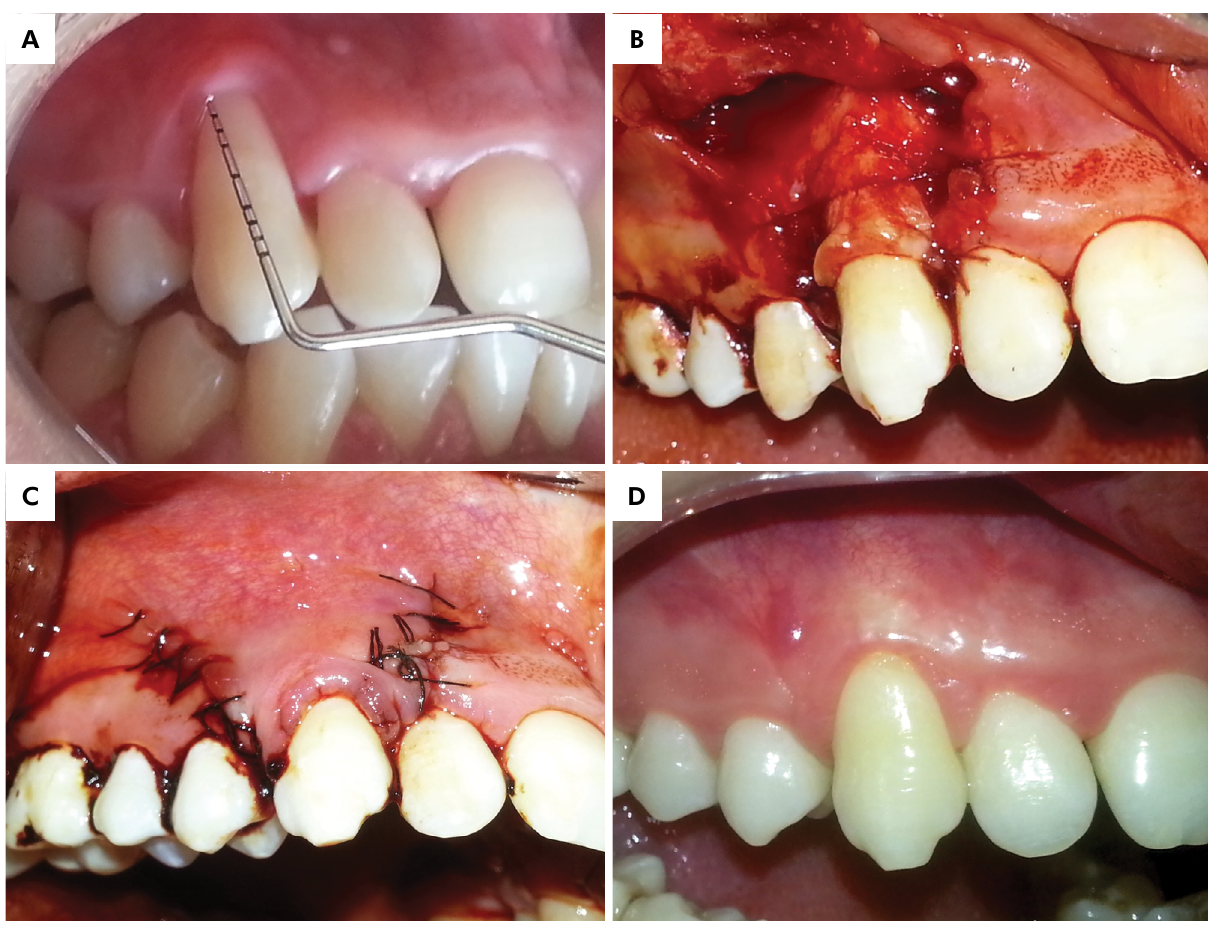
Figure 1. A. Gingival recession in right canine; B. EMD application and SCTG placement; C. Suturing; D. One year